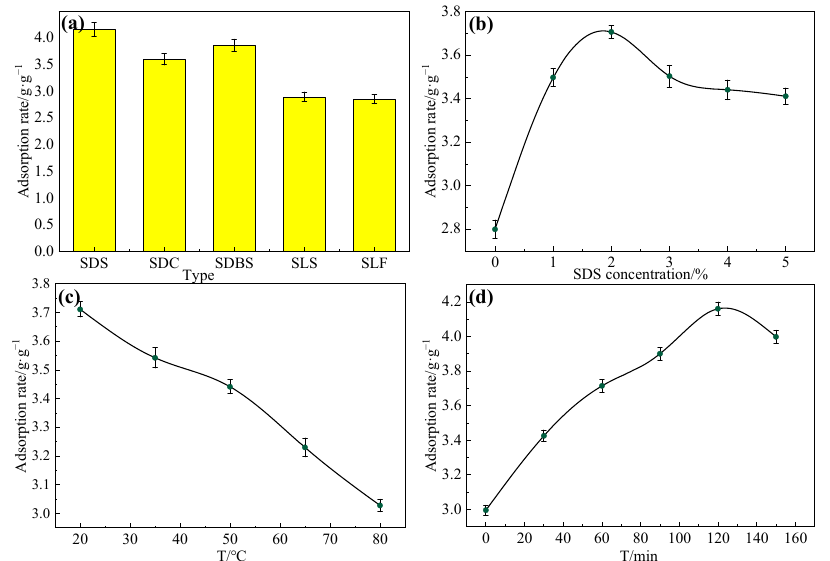
Figure 3. ( a ) Effect of anionic surfactant type under the concentration of 2% and reacting for 120 min at 20 ◦ C. ( b ) Effect of SDS concentration under 2 ◦ C and reacting for 120 min. ( c ) Effect of surface modification temperature under 2% CTAC and reacting for 120 min. ( d ) Effect of surface modification time under the concentration of 2% at 20 ◦